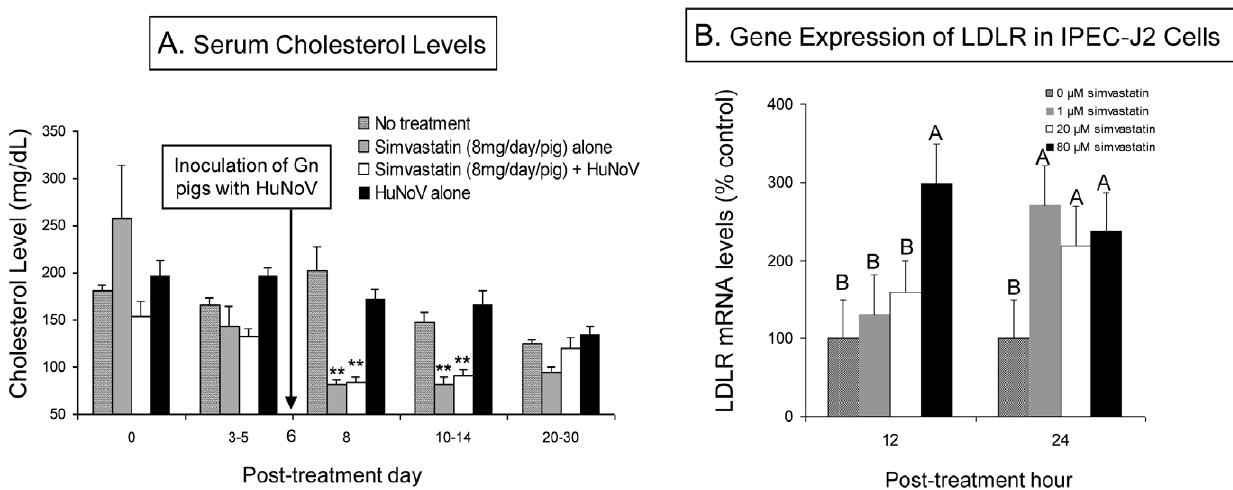
Figure 1. Simvastatin treatment lowers the serum cholesterol level in Gn pigs and results in increased early LDLR gene expression in IPEC-J2 cells. ( A ) Total serum cholesterol levels were assessed in all animals of 3 independent trials ( n =6 to 11 pigs at each time-point for Simvastatin + HuNoV and HuNoV alone; n=2 to 4 pigs at each time-point for Mock and Simvastatin alone) by using an Amplex Red cholesterol assay kit. Pigs were inoculated with HuNoV at 6 days after simvastatin treatment began, i.e. when lower serum cholesterol levels were detected in treated animals compared to pre-treatment levels. Each bar represents the mean 6 SEM. ** P , 0.01 for simvastatin treatment groups vs Mock (or HuNoV alone) at each time-point. ( B ) LDLR gene expression levels in IPEC-J2 cells treated with various concentrations (0, 1 m M, 20 m M, and 80 m M) of simvastatin. LDLR gene expression was analyzed by qRT-PCR at 12 and 24 hours after treatment. Each bar represents the mean 6 SEM. Different letters denote significant differences among groups at each time-point (ANOVA test, P , 0.05). Data from 2 independent experiments were combined, and each test was performed in triplicate.